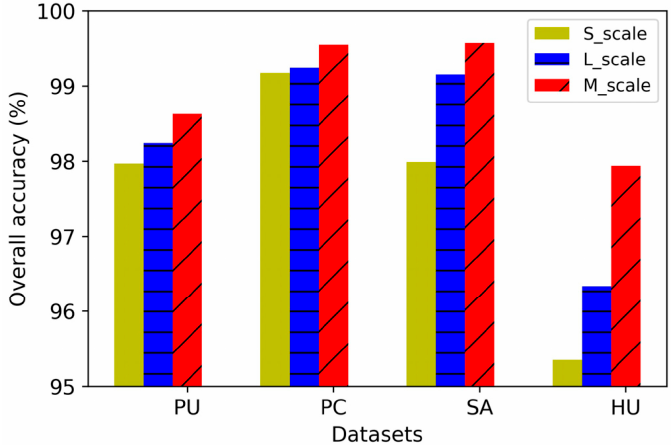
Figure 12. Effectiveness of multiscale inputs.